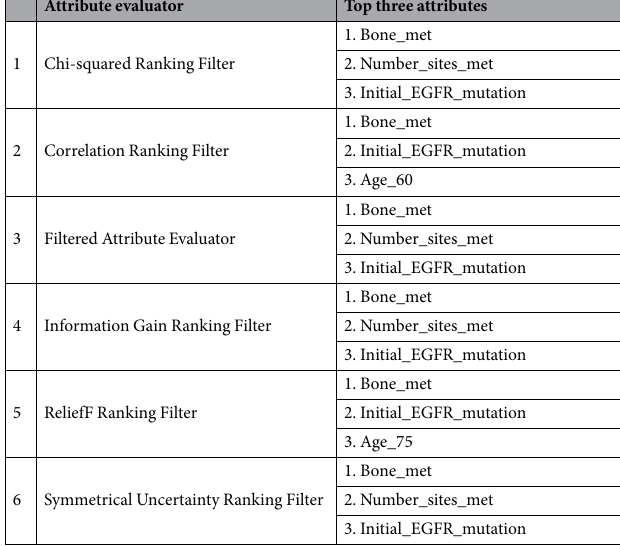
Table 2. Attribute ranking results.